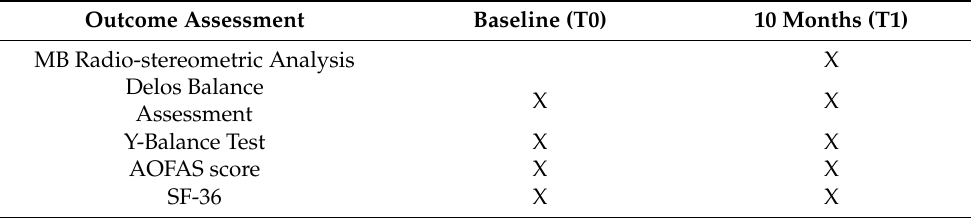
Table 2. Outcome timeline.